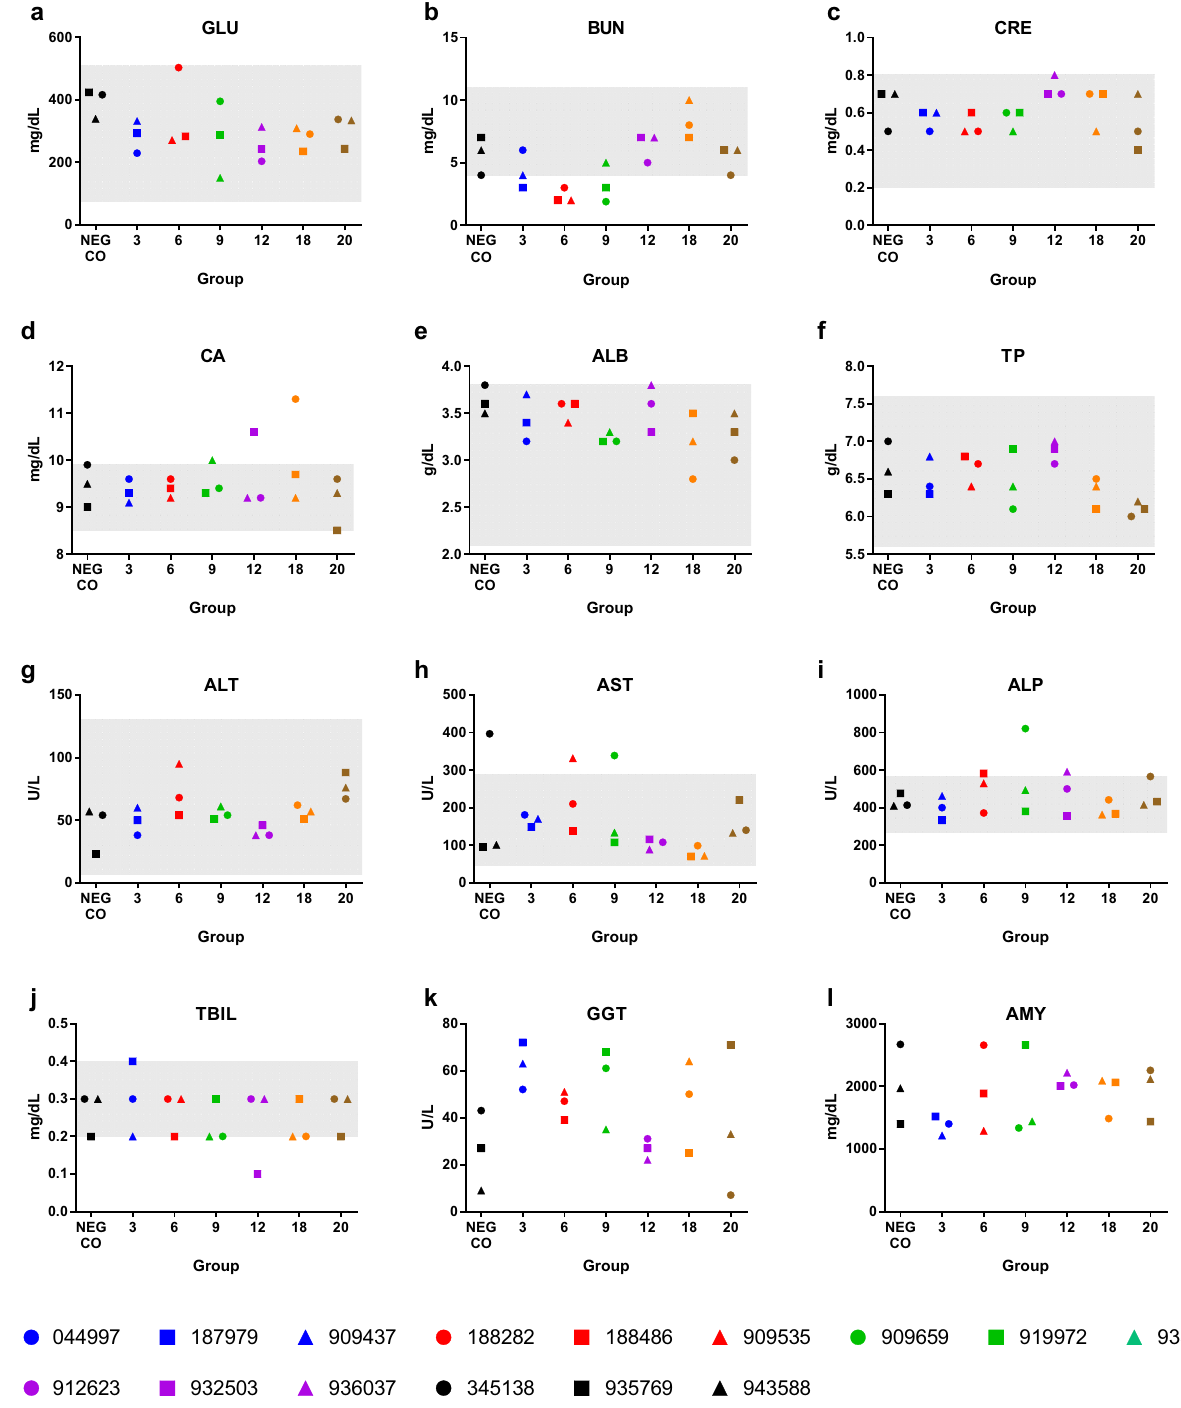
Figure 6. Clinical chemistry analytes measured in negative control (NEG CO) and Kasokero virus- inoculated bats euthanized at 3, 6, 9, 12, 18, or 20 days post inoculation. ( a ) glucose (GLU), ( b ) blood urea nitrogen (BUN), ( c ) creatinine (CRE), ( d ) calcium (CA), ( e ) albumin (ALB), ( f ) total protein (TP), ( g ) alanine transaminase (ALT), ( h ) aspartate transaminase (AST), ( i ) alkaline phosphatase (ALP), ( j ) total bilirubin (TBIL), ( k ) gamma-glutamyl transferase (GGT), and ( l ) amylase (AMY). Gray-shaded areas in ( a – j ) depict normal reference